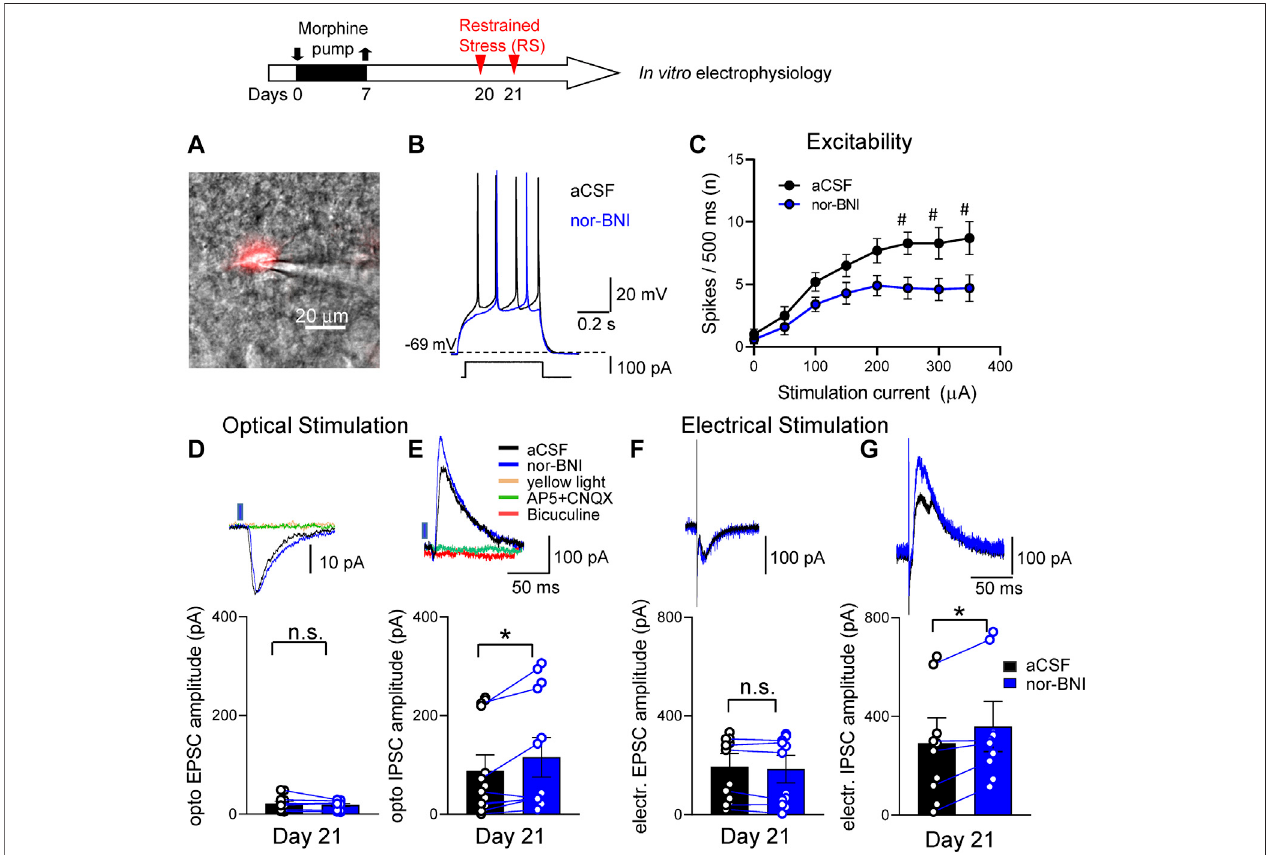
FIGURE6| EffectsofaKORantagonistonexcitatoryandinhibitorysynaptictransmissioninCRF-CeAneuronsinafunctionalpainmodel.Timelineofexperimental proceduresisshown atthetopoftheFigure.Recordings ofvisuallyidenti fi edCeA-CRF neuronsweremadeinwhole-cellcon fi guration. (A) ACRF-CeAneuronisshown with fl uorescence (for mCherry) illumination. (B) Traces of a late- fi ring neuron (shown in A ) during aCSF and nor-BNI (1 μ M) application. Nor-BNI decreased neuronal fi ring evoked by depolarizing current injection. (C) Application of nor-BNI decreased excitability ( F – I relationship) of CeA-CRF neurons in brain slices from rats with functionalpain syndrome model ( # p < 0.05, ANOVA RM, Sidak ’ s posthoc test, n =10). (D,F) Excitatory postsynaptic currents (EPSCs) evoked by optical stimulation (D) ofChR2expressingterminalsorbyelectricalstimulation (F) ofparabrachial fi berswerenotaffectedbyadministrationofnor-BNI(1 μ M)( p > 0.05,paired t -test,compared toaCSF;optical, n =8,electrical n =6).Tracesabovegraphsshowindividualexamples.OpticallyevokedEPSCswereblockedbyAP5andCNQX.Yellowlight(590 nm) stimulation as an inactive control did not evoke any responses. (E,G) Inhibitory postsynaptic currents (IPSCs) evoked by optical stimulation (E) and electrical stimulation (G) of parabrachial fi bers were signi fi cantly increased by administration of nor-BNI (* p < 0.05, paired t -test, compared to predrug aCSF; optical, n = 8; electrical, n = 6). Traces show individual examples. Bicuculine as well as AP5 and CNQX blocked optical IPSCs. Yellow light stimulation served as a control. EPSCs and IPSCs were recorded at — 70 and 0 mV, respectively. Bar histograms show means ± SEM. Symbols show values of individual neurons.